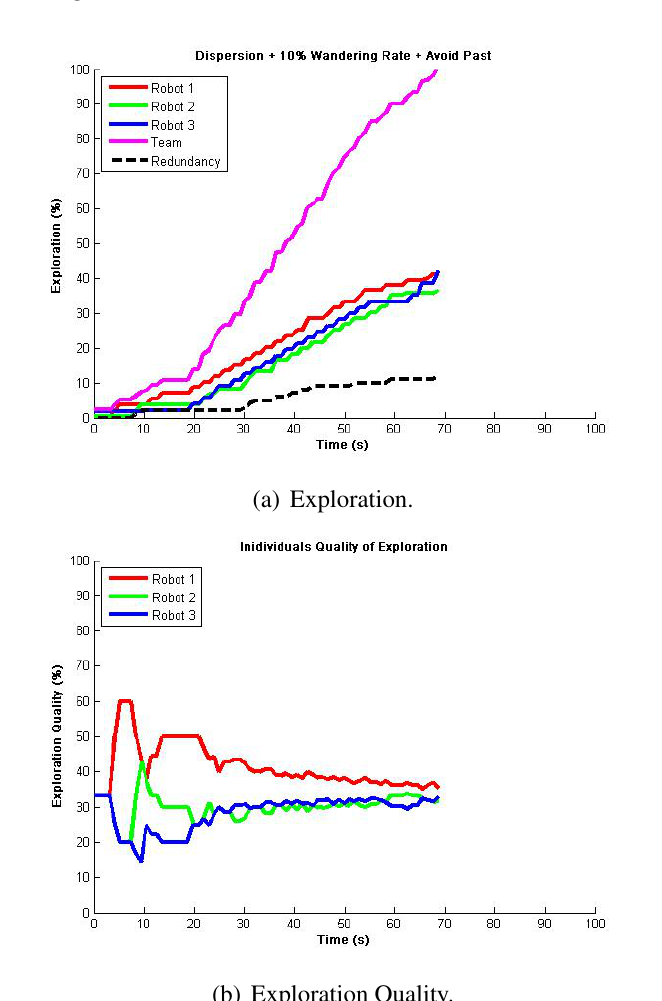
Figure 6. Autonomous exploration showing representative results in a single run for 3 robots avoiding their own past. Full exploration is completed at almost 3 times faster than using a single robot, and the exploration quality shows a balanced result meaning an efficient resources (robots)